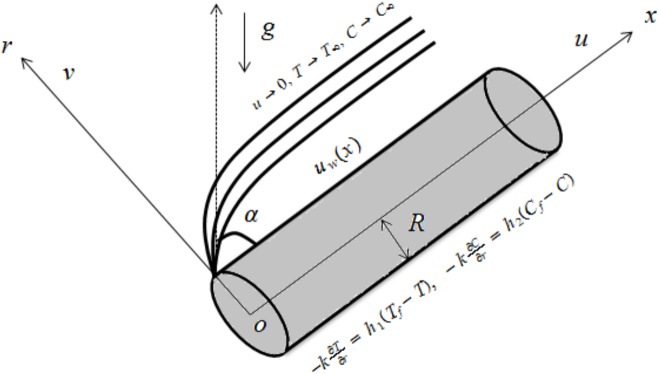
Physical diagram.